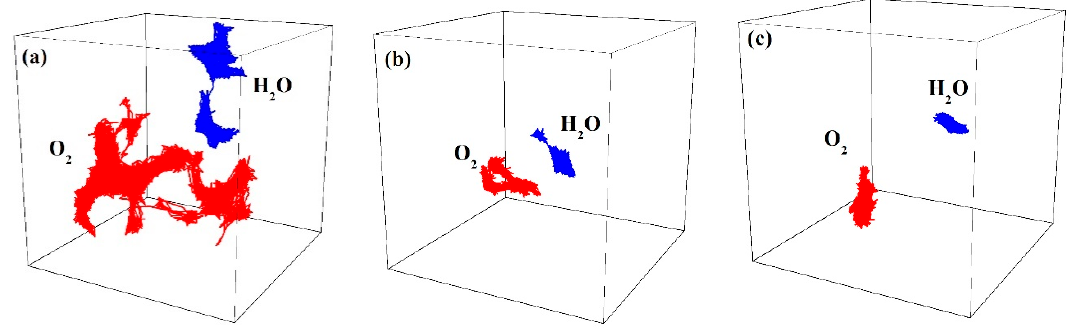
Figure 12. The representative trajectories of O 2 and H 2 O in ( a ) Kapton, ( b ) 2,7 ‐ CPPI and ( c ) 2,7 ‐ CPI.